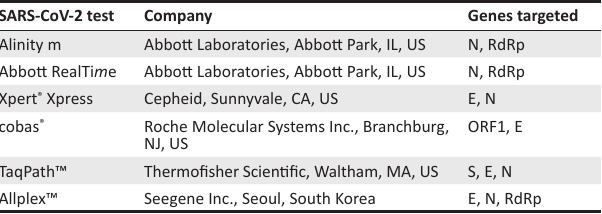
TABLE 1: SARS-CoV-2 molecular tests in South African public sector